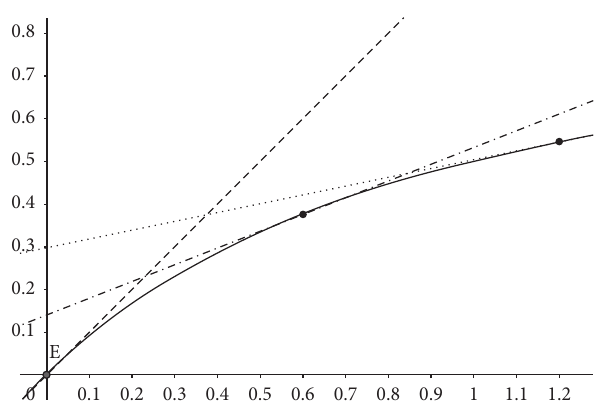
Figure 5: Piecewise linear graph. It shows that the line of a nonlinear function can be approximated by a set of